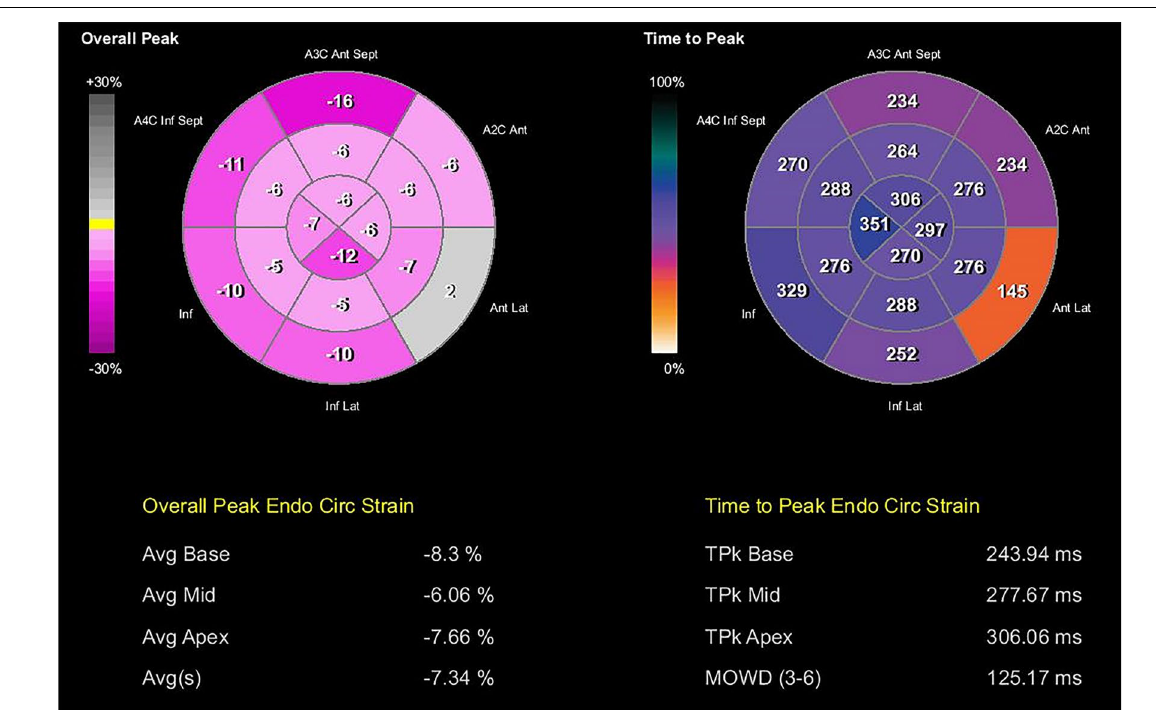
Fig. 7 Bull’s eye plot of left ventricular circumferential strain and time to peak circumferential